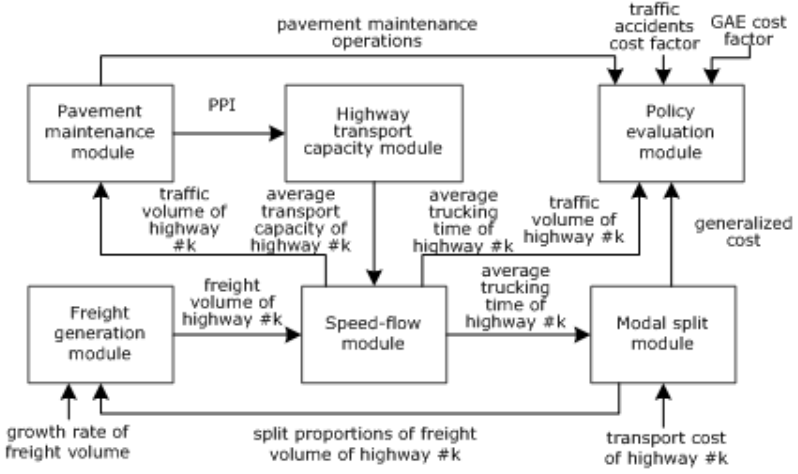
Figure 2. Framework of the SD